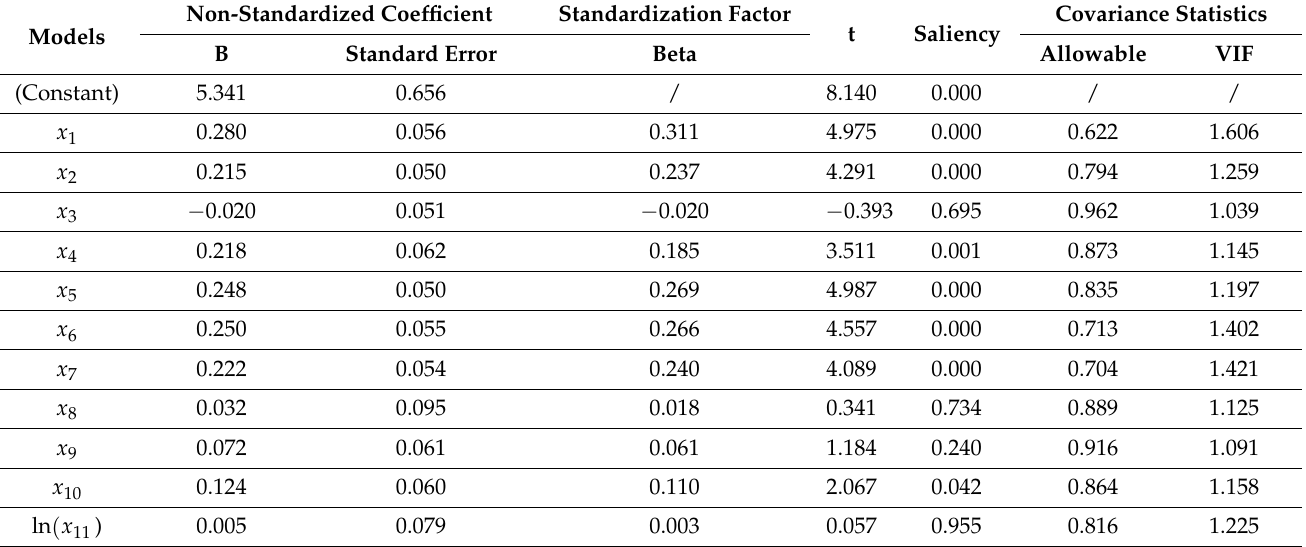
Table 6. Regression Analysis.